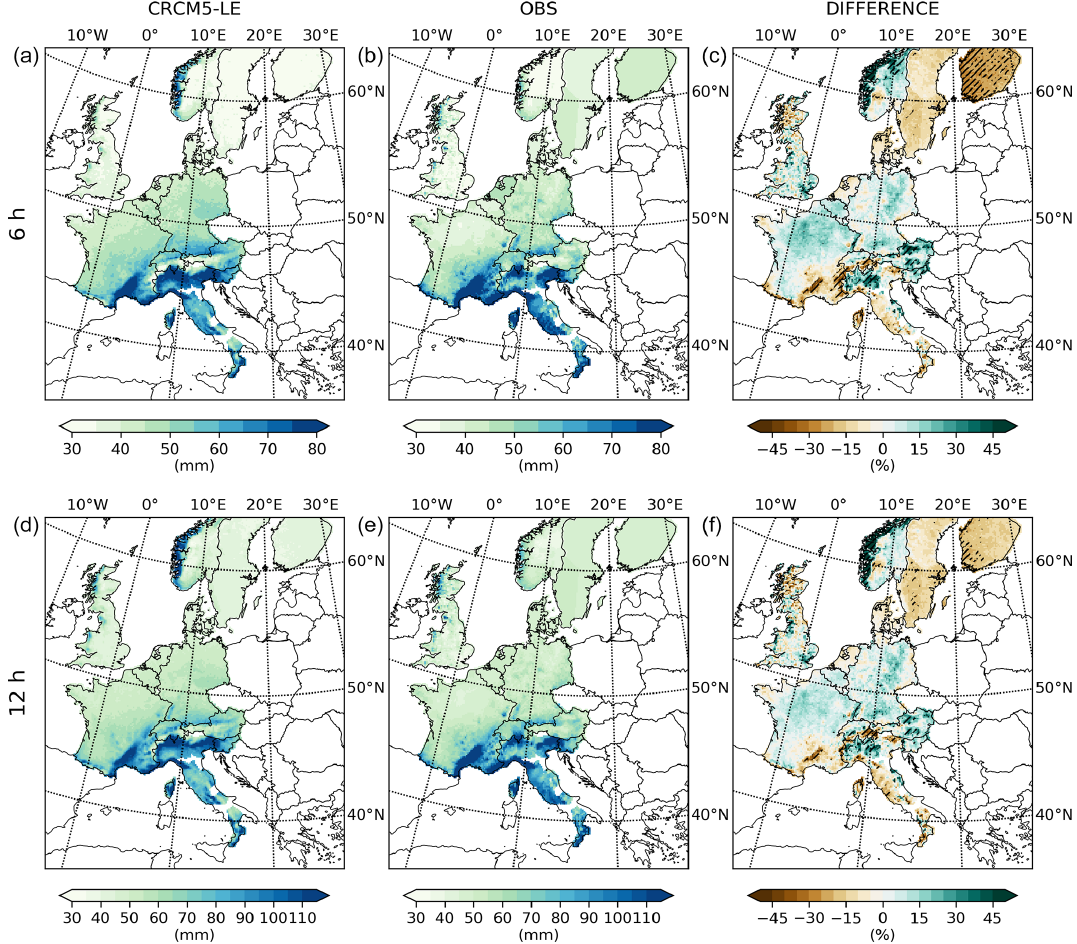
Figure 3. The 10-year return levels of 6 (a–c) and 12h (d–f) precipitation over parts of Europe. The CRCM5- LE data (a, d) are compared to an observational data set (b, e) , and the percentage deviation (c, f) is shown. Areas where the observations are not in the range of the CRCM5-LE are